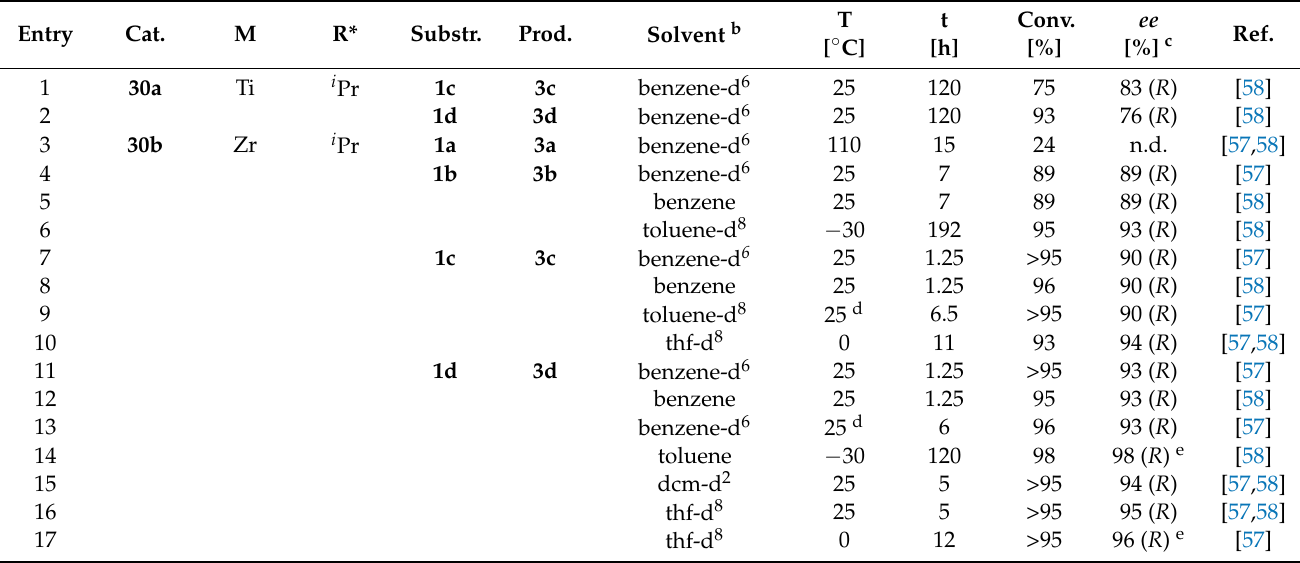
Table 10. Catalytic asymmetric hydroamination of 1a – f , 2c , d and 38 – 40 using chiral group IV catalysts 30a – c and 31 a